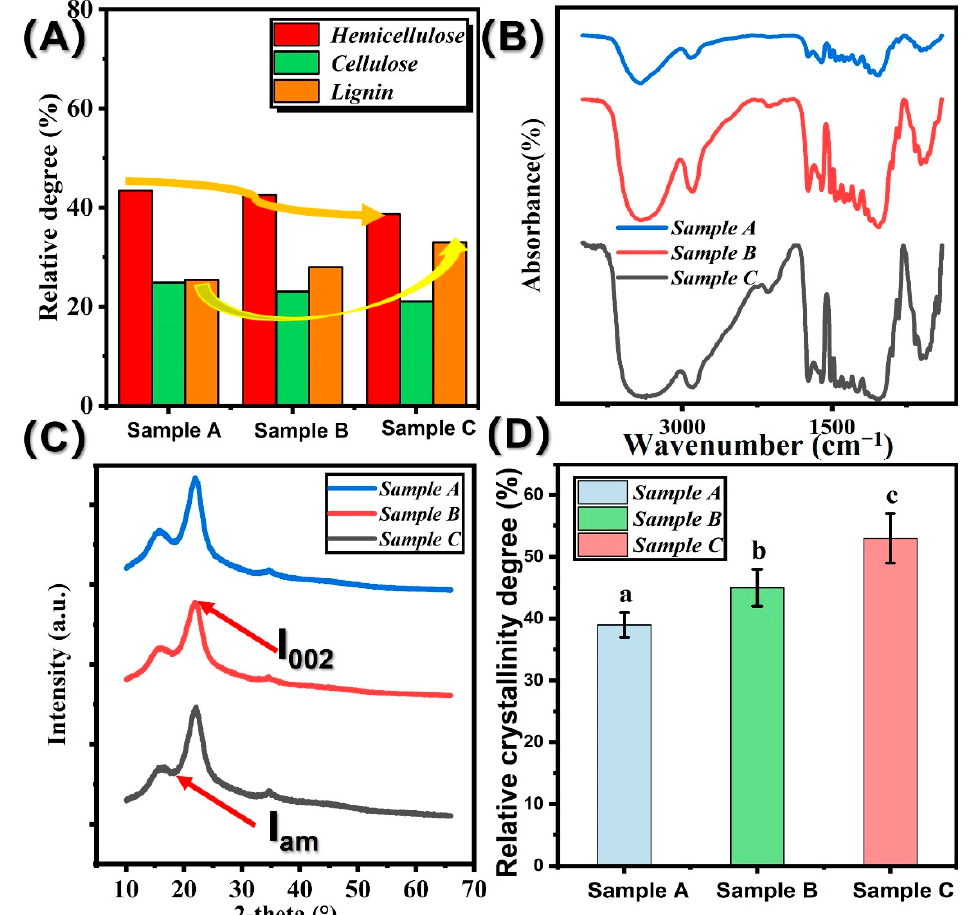
Figure 4. The change in chemical composition, cellulose crystallinity, chemical groups of different bamboo samples: ( A ) hemicellulose, cellulose, and lignin; ( B ): XRD curves; ( C ) Relatively crystallinity degree; ( D ) FTIR curves of different bamboo samples. Different small letters represent the significant difference between heat treatment groups ( p < 0.05). The error bar in the picture represents the standard